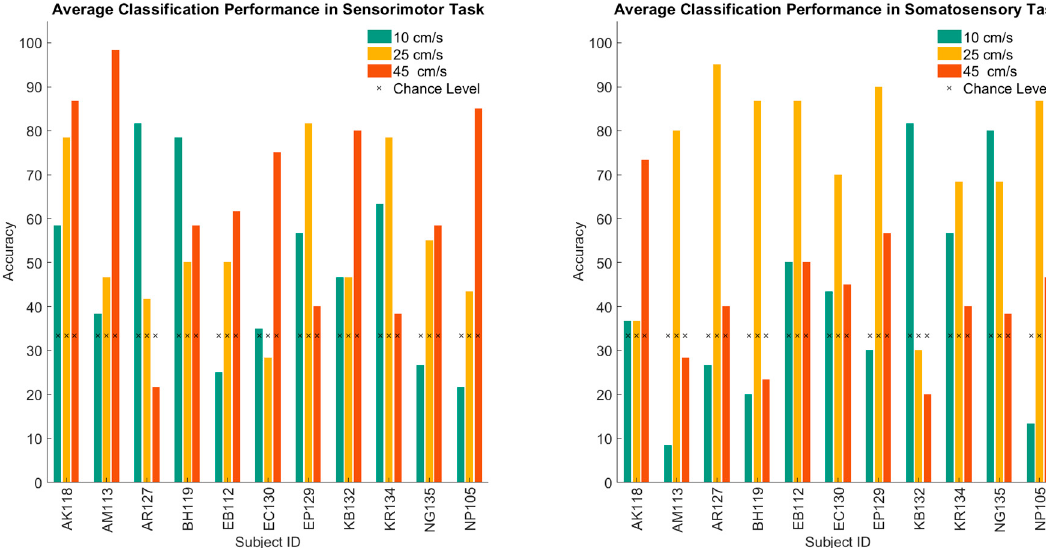
Figure 5. Average classification performance of tri-classifiers in distinguishing the three velocities of 10 cm/s (Green), 25 cm/s (Yellow), and 45 cm/s (Red) in Active (left panel) and Passive (right panel) tasks.